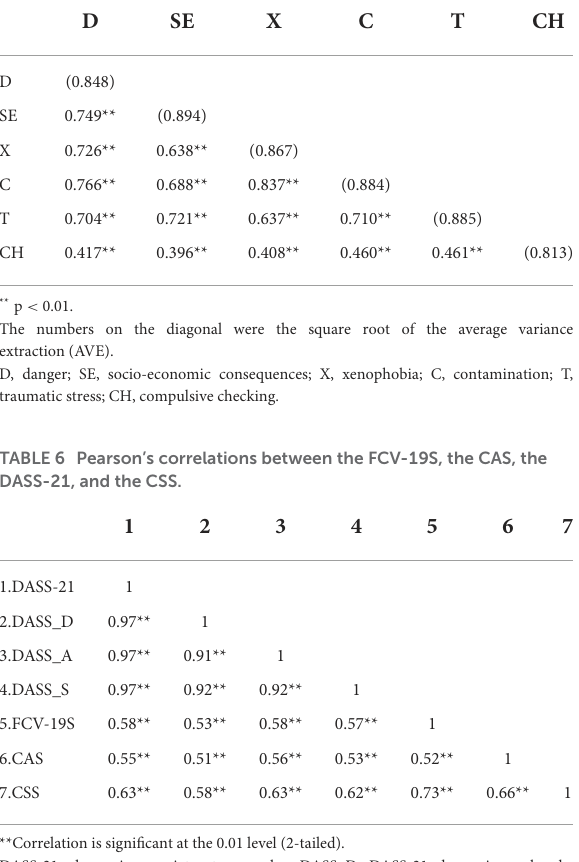
TABLE 4 Convergent validity ( n = 2,116). TABLE 5 Discriminant validity ( n =